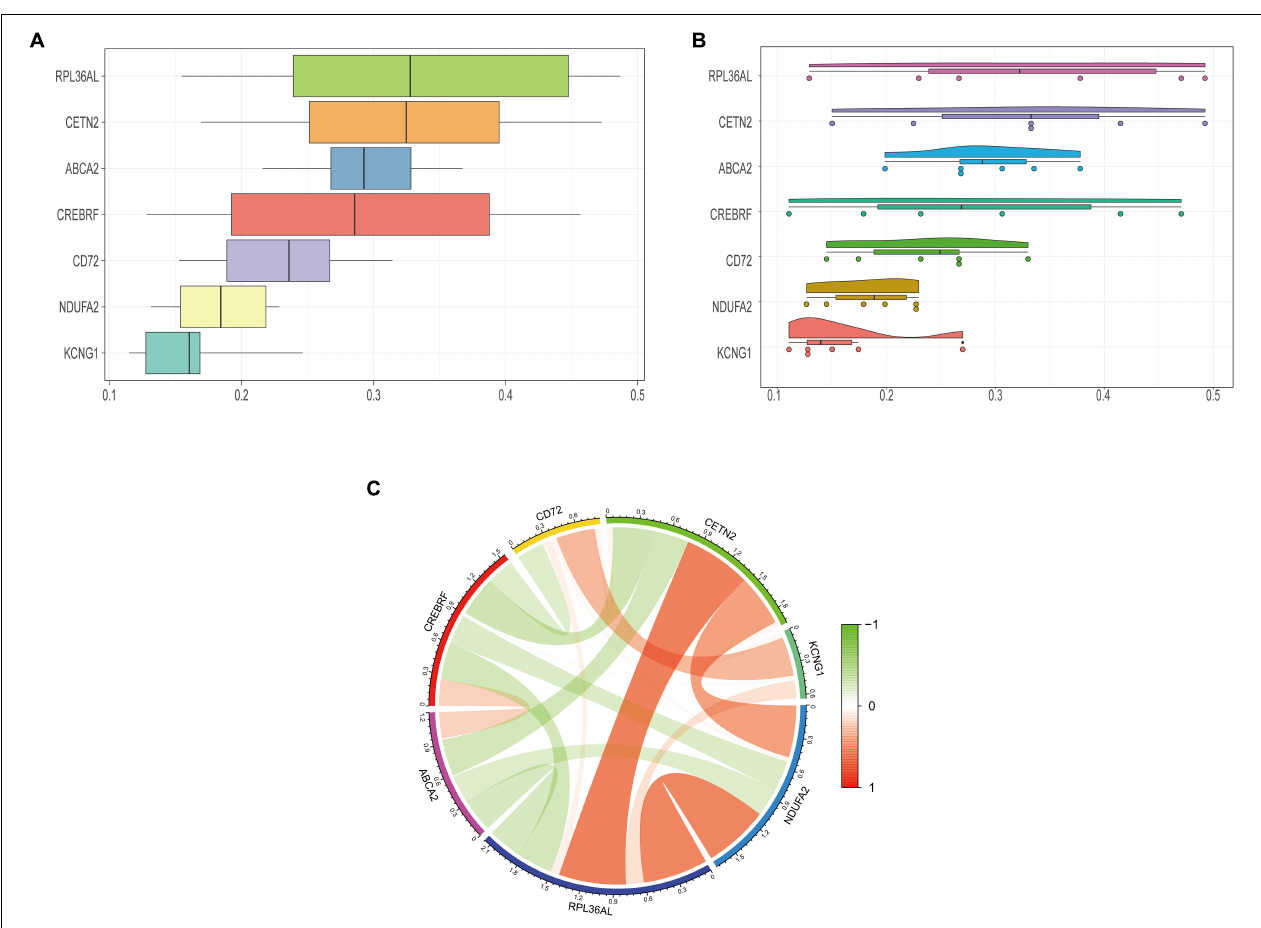
FIGURE 6 | Closeness score of semantic similarities between GO terms and coexpression analysis of hub genes. (A) GO semantic similarity box plot of core genes. (B) Raincloud plot of relatedness of the GO terms. (C) The circos diagram depicts Pearson correlations between hub genes.